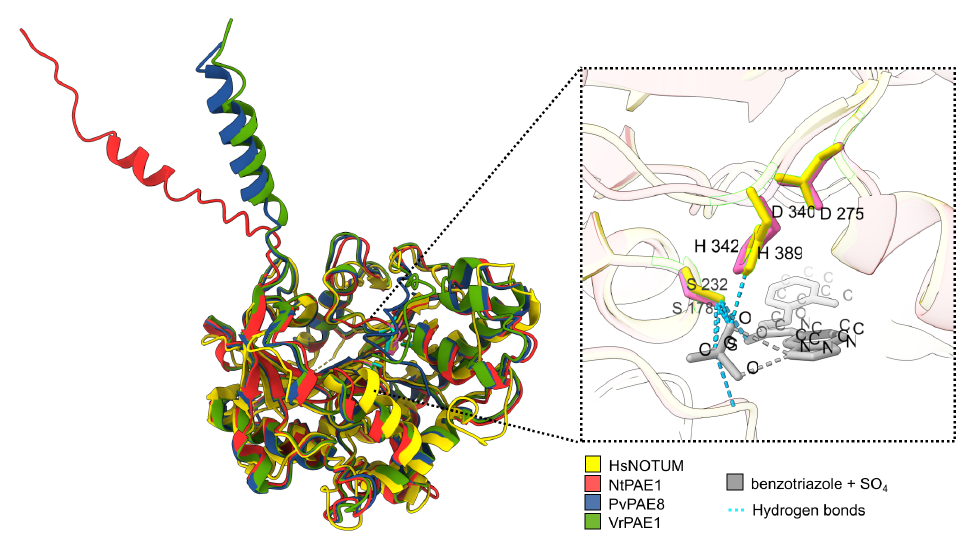
Figure 3. Plant PAEs are structurally similar to human NOTUM. Structural superposition of NtPAE1, PvPAE8, and VrPAE1 with HsNOTUM as a reference. The active site residues are structurally similar between all four proteins. The detail shows NOTUM active site residues (yellow) and putative active site of NtPAE1 (pink). The SO 4 and benzotriazole molecules are ligands of NOTUM (PDB entry 6RQ8). NtPAE1 predicted active site residues = S178, D275, H342. HsNOTUM active site residues = S232, D340,